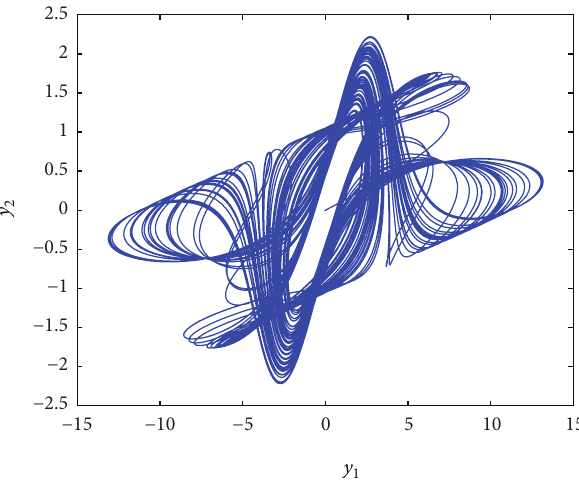
Figure 4: Chaotic attractors of memristor chaotic oscillator system described by